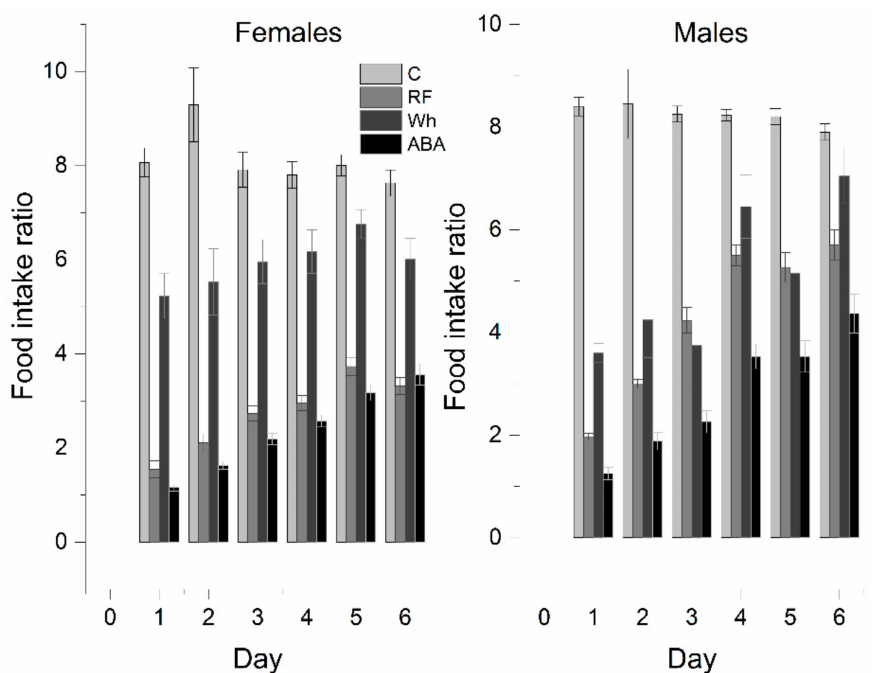
Figure 4. Food consumption of the experimental rats calculated as grams of food per 100 g of body